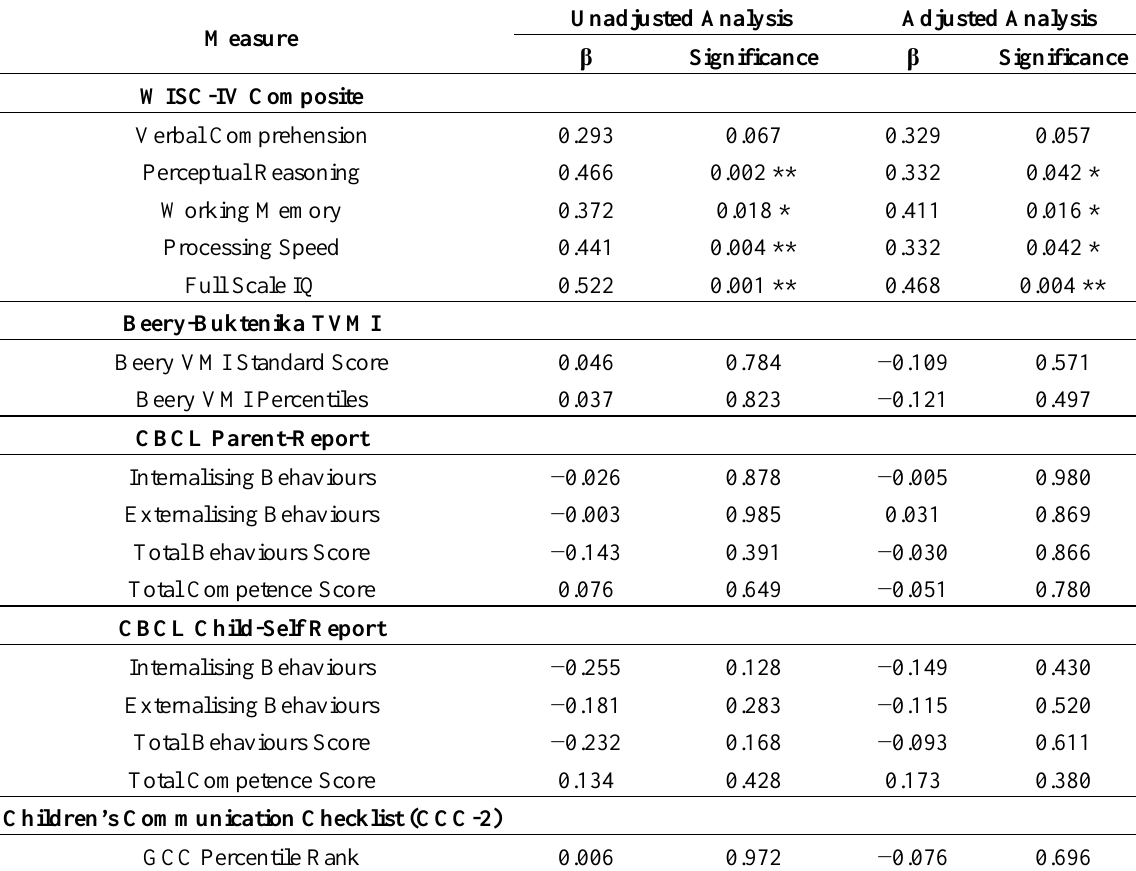
Table 4. Association between DHA and neurodevelopmental outcome at 12 years